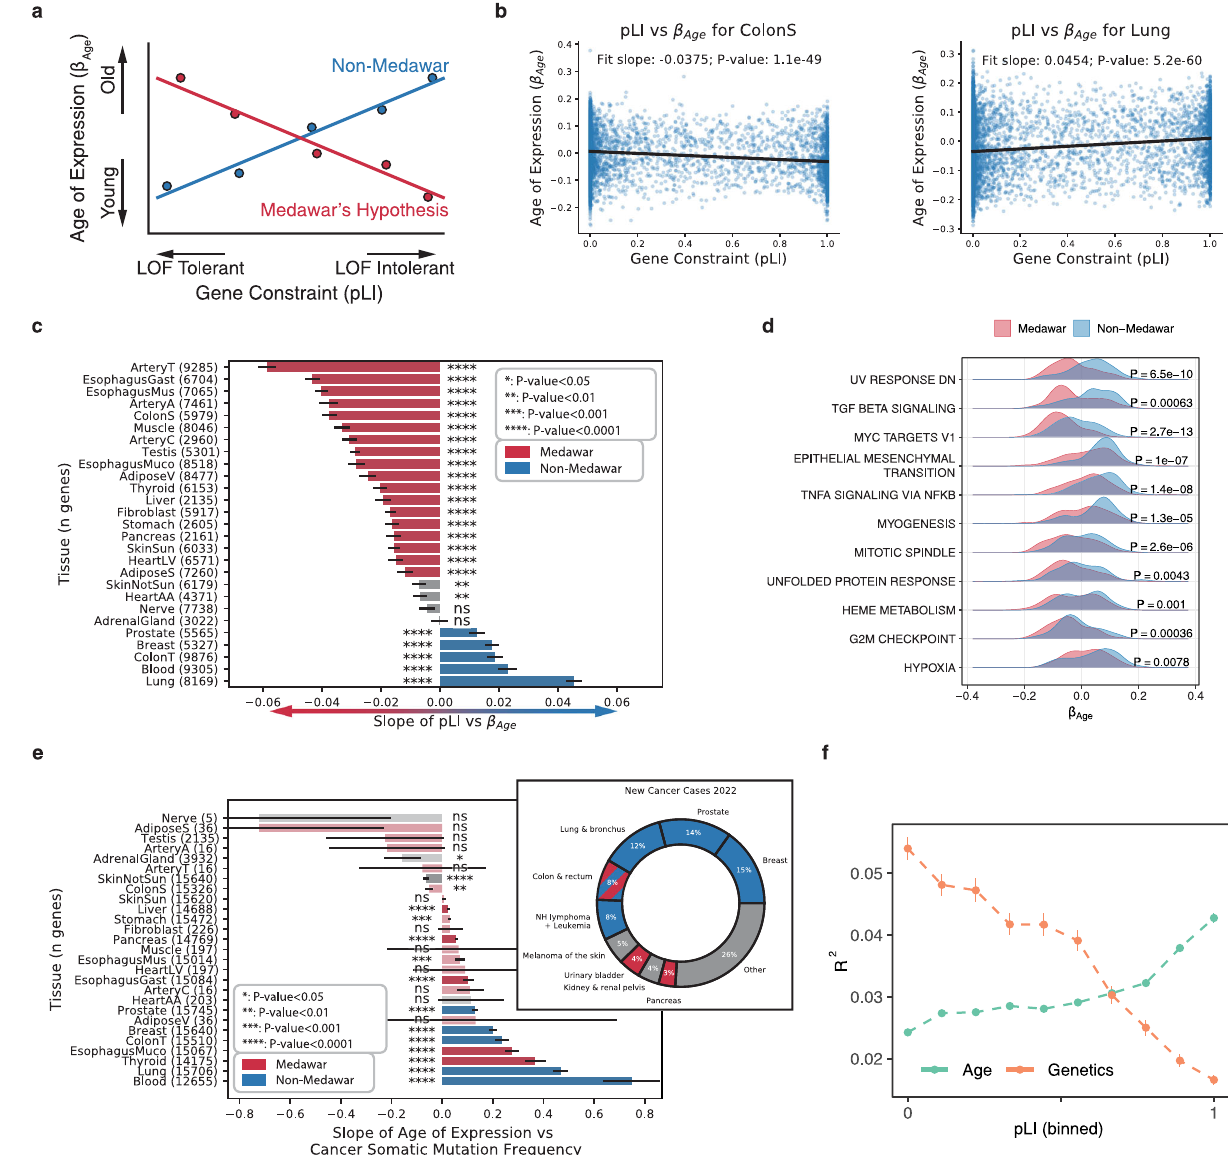
tionship across genes between the per-gene age-associated slope of gene expres- sion( β age )andagene'slevelofconstraint(measuredbyprobabilitylossoffunction intolerance, pLI). Medawar's hypothesis predicts a negative relationship (shown in red)betweenthetimeofexpressionandthelevelofconstraint.Theoppositetrend (non-Medawar)isshowninblue. b β age acrossgenesplottedasafunctionofpLIfor